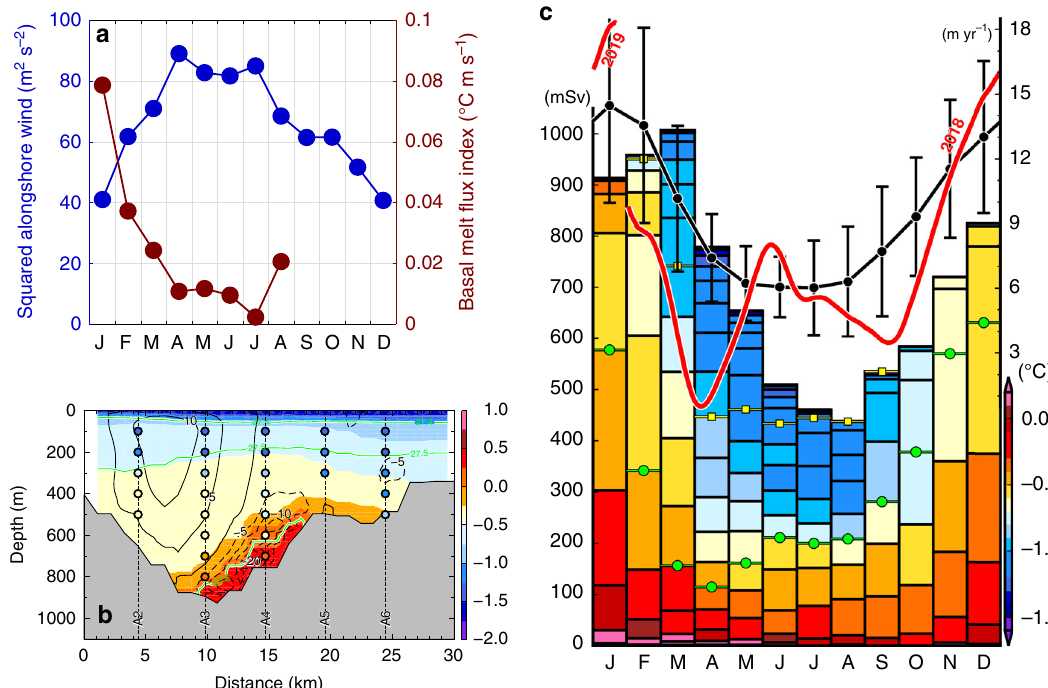
Fig. 7 Clear seasonal cycle of SGT basal melting. a Monthly mean basal melt fl ux index at 300 dbar of Sta.P2 near the ice front (brown, see also Fig. 6c) and monthly mean squared alongshore (southwestward) wind speed averaged for 1979 – 2017 at the northeast continental slope (blue, equivalent to wind stress). Average of wind speed at two locations (red squares in Fig. 1a) are used here as the representative wind fi eld on the northeast slope region of LHB. b Across-trough vertical section of simulated climatology of temperature (color) and northward current velocity (broken contours represent southward current velocity) in January (averaged for 2006 – 2017, results from the simulation without fast ice: NOFI case, see Methods). Each color of dot denotes observed temperature in January 2017 (see also Fig. 2d). Green contours indicate σ θ = 27.4, 27.5 and 27.6 kg m − 3 . c Simulated seasonal cycle of SGT basal melt rate with a range of one standard deviation (black line, right axis) and water mass fl owing into the cavity (boxes, left axis) across the SGT ice front, by the coupled ocean – sea ice – ice shelf model. Color of boxes denote temperature ( o C). The volume fl ux is integrated every 0.02 kg m − 3 , and horizontal yellow and green lines with dot on each month represent σ θ = 27.4 and 27.5kg m − 3 , respectively. Time series of ApRES-derived basal melt rate (from